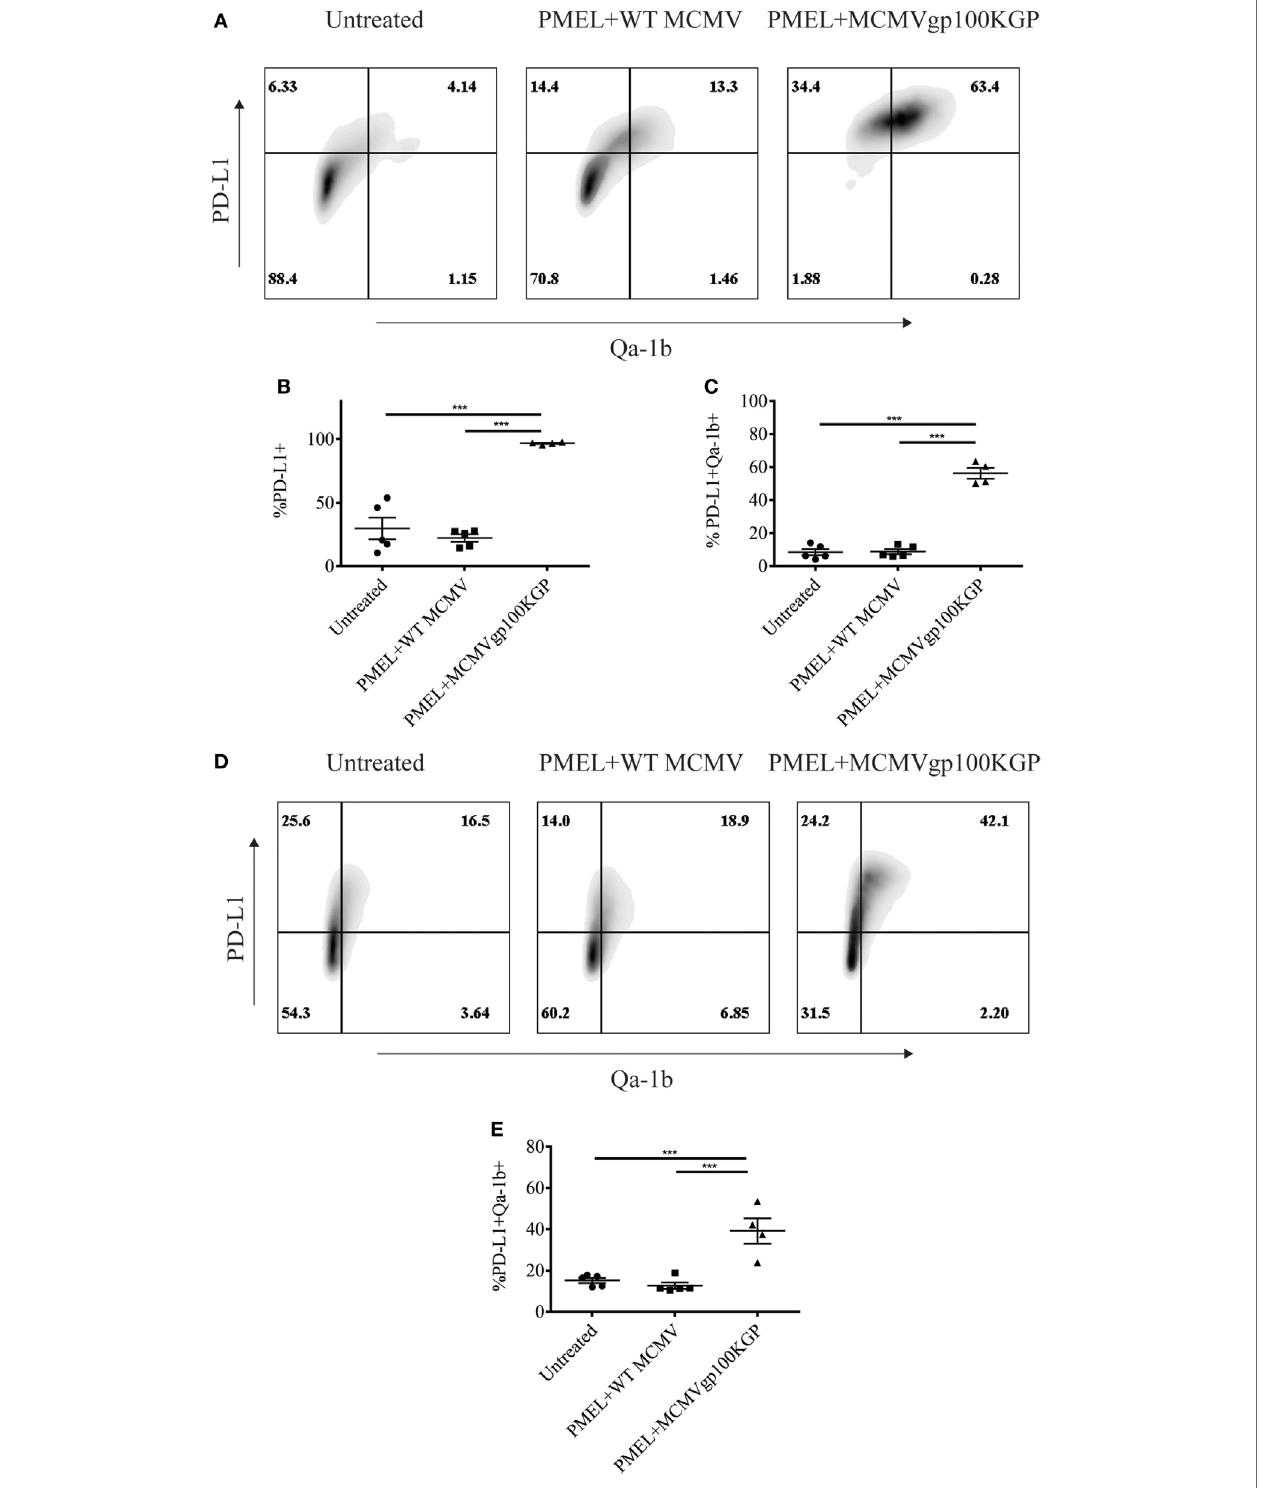
FigUre 6 | MCMVgp100KGP vaccination induces expression of PD-L1 and Qa-1 b within B16 tumors. Mice were challenged with B16F10 expressing RFP (B16RFP) i.d. and 5 days later left untreated, treated with PMEL transfer i.v. and 10 5 PFU wild-type (WT) MCMV i.p., or treated with PMEL transfer i.v. and 10 5 PFU MCMVgp100KGP i.p. Six days later, tumor tissue was harvested for flow cytometry. (a) Representative plots of RFP + tumor cells. (B) Percentage of RFP + cells expressing PD-L1. (c) Percentage of RFP + cells expressing PD-L1 and Qa-1 b . (D) Representative plots of CD45 + CD8 − TIL. (e) Percentage of CD45 + CD8 − TIL expressing PD-L1 and Qa-1 b . *** p < 0.001; n = 4–5 mice/group. Data are representative of three independent experiments.